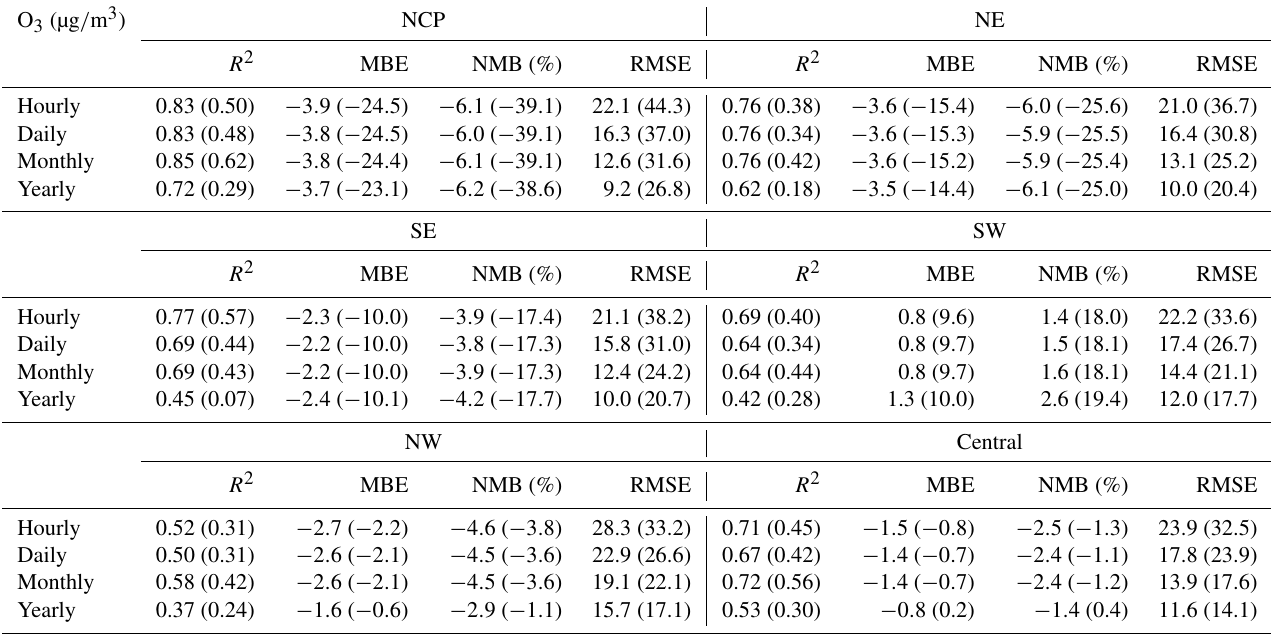
Table E6. CV results of the reanalysis (outside brackets) and base simulation (in brackets) for O 3 concentrations in different regions of China on different temporal